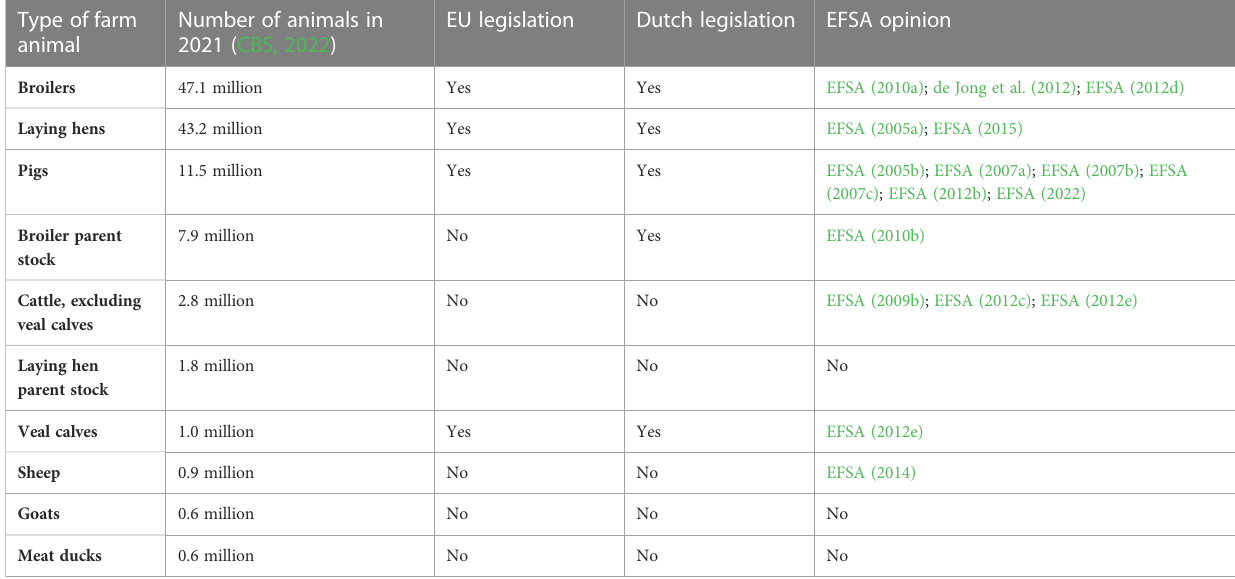
TABLE 5 The top 10 farm animals kept for commercial purposes in the Netherlands, based on numbers in 2021, and the availability of relevant species-speci fi c EU or Dutch legislation and EFSA opinions. Type of